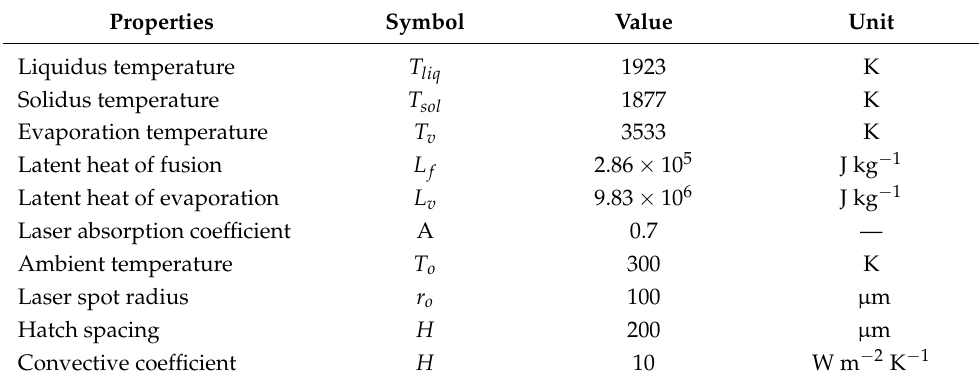
Table 3. Material properties of Ti6Al4V alloy and constant simulation process